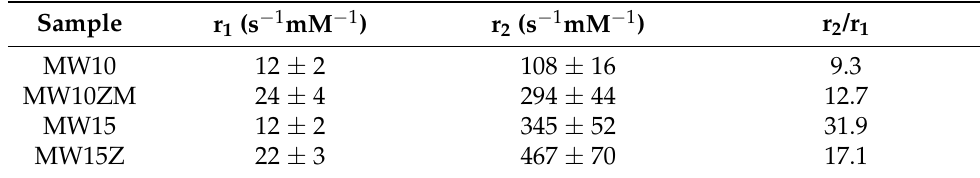
Table 2. Longitudinal and transverse r 1,2 values of the selected samples resulting from the linear fit of the relaxation rates acquired as a function of the iron concentration at 1.5